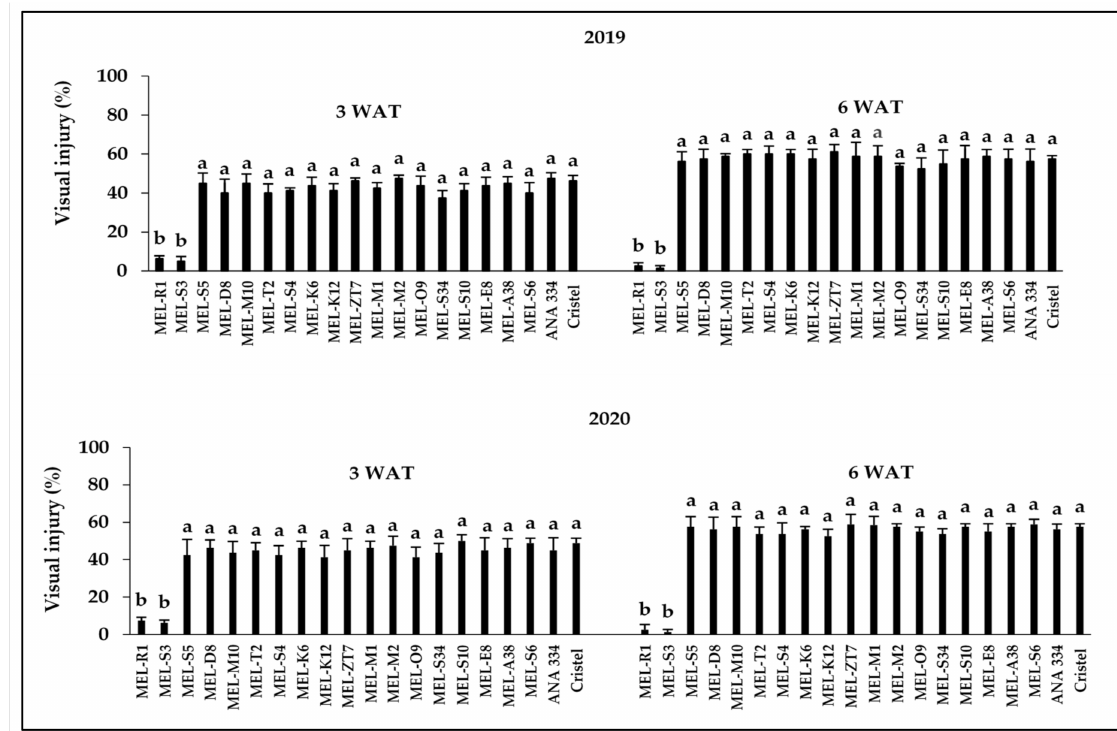
Figure 1. Response of melon accessions and commercial cultivars to 2,4-D application at the rate of 3.7 g ae ha − 1 3 and 6 weeks after treatment during 2019 and 2020. Means in each chart followed by different letters are significantly different at p ≤ 0.05 using LSD test.